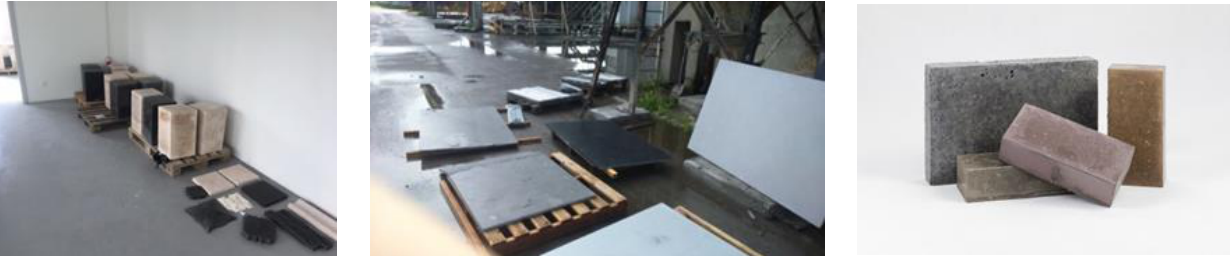
Figure 7. Examples of geopolymer products manufactured on a semi-technical scale in Poland (source—own research).